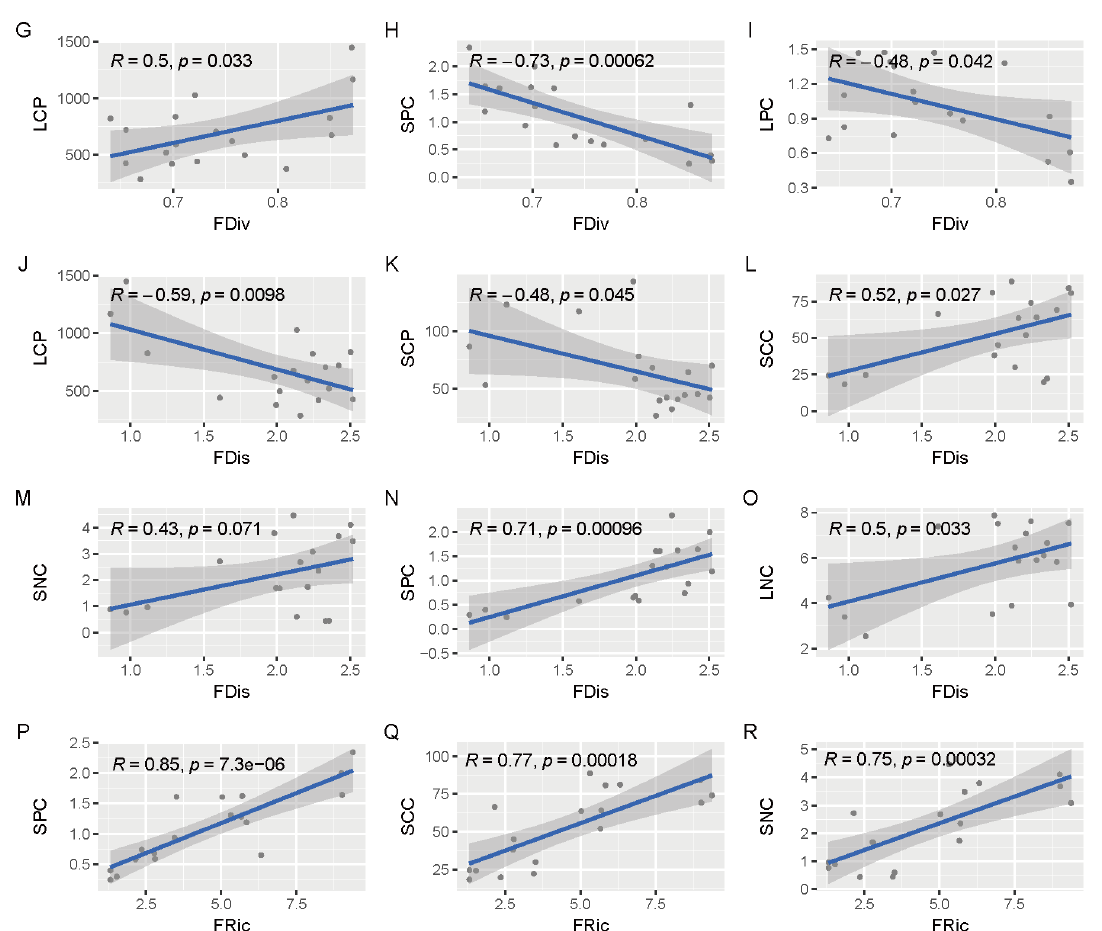
Figure 7. Linear plots of the correlation between functional diversity and leaf and soil properties. R represents the magnitude of correlation between the two variables, p represents the magnitude of significance, and when p ≤ 0.05, it indicates a significant correlation between the two variables.